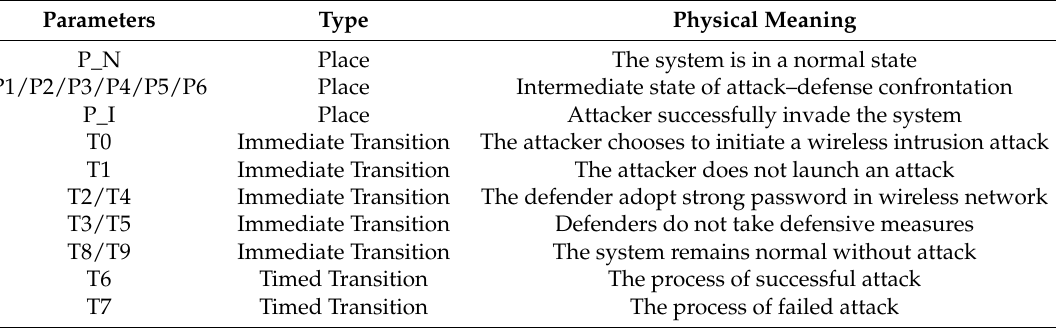
Figure 3. Attack–defense confrontation model in the penetration phase. Table 3. Model parameters in the penetration